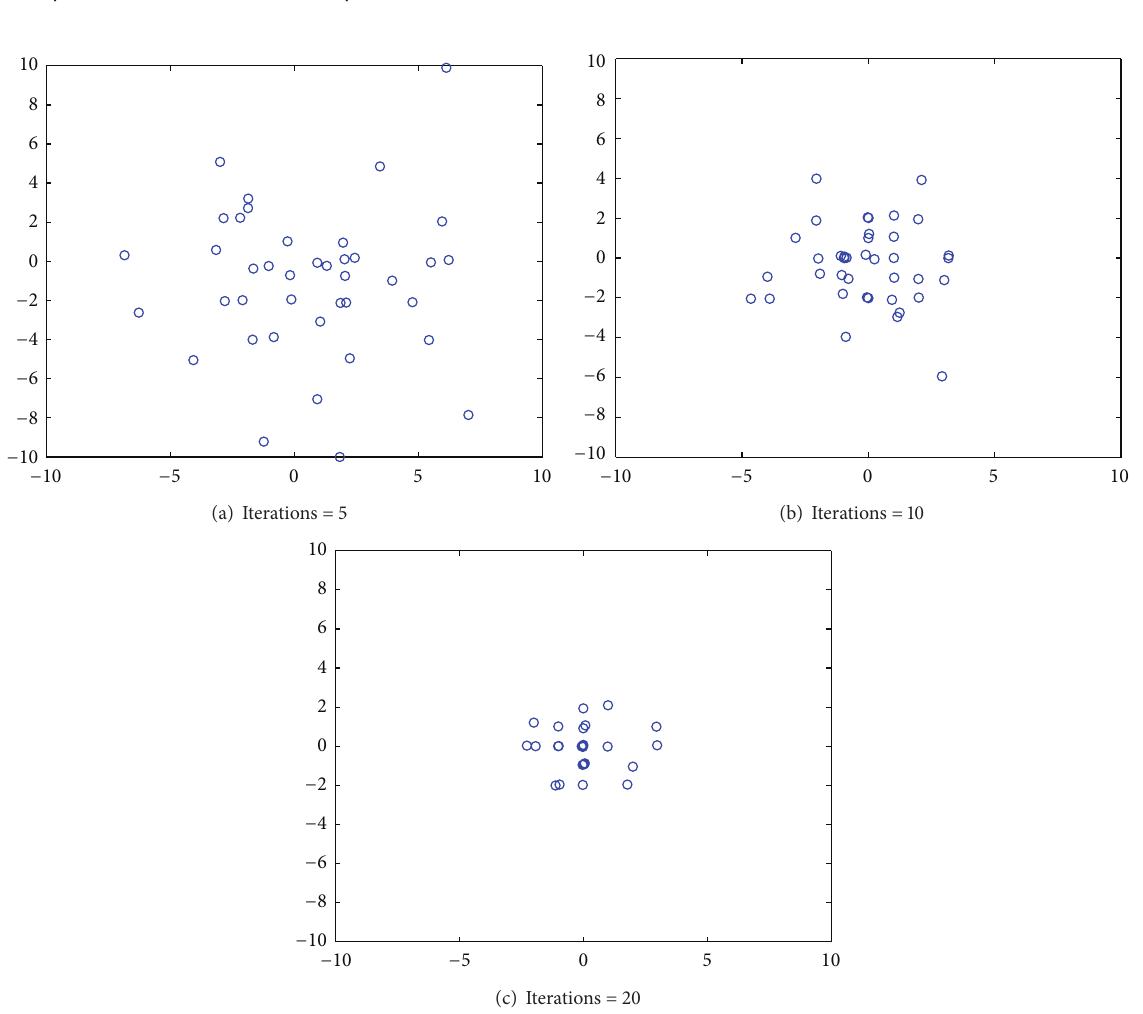
Figure 2: Population distribution observed at various stages in ABC with time-varying strategy.